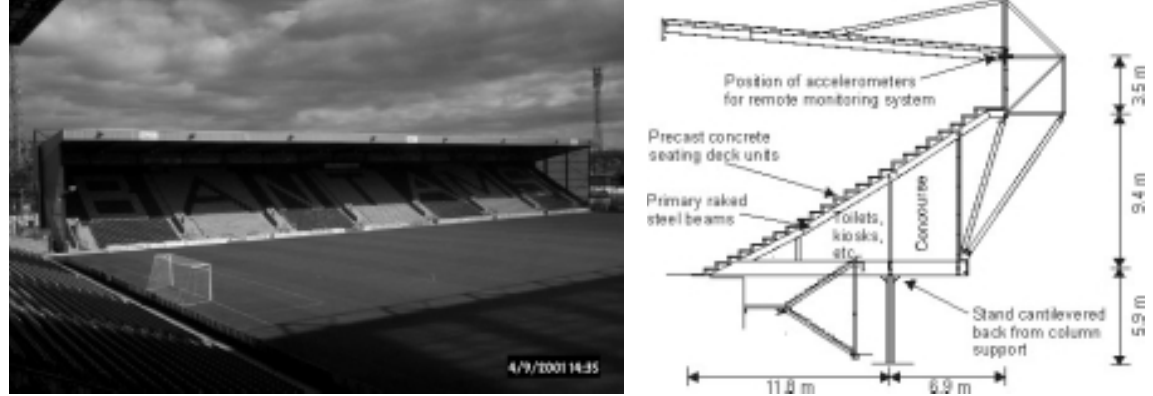
Fig. 1. (Left) Midland Road Stand at the Bradford and Bingley Stadium. (Right) Cross section with accelerometer locations